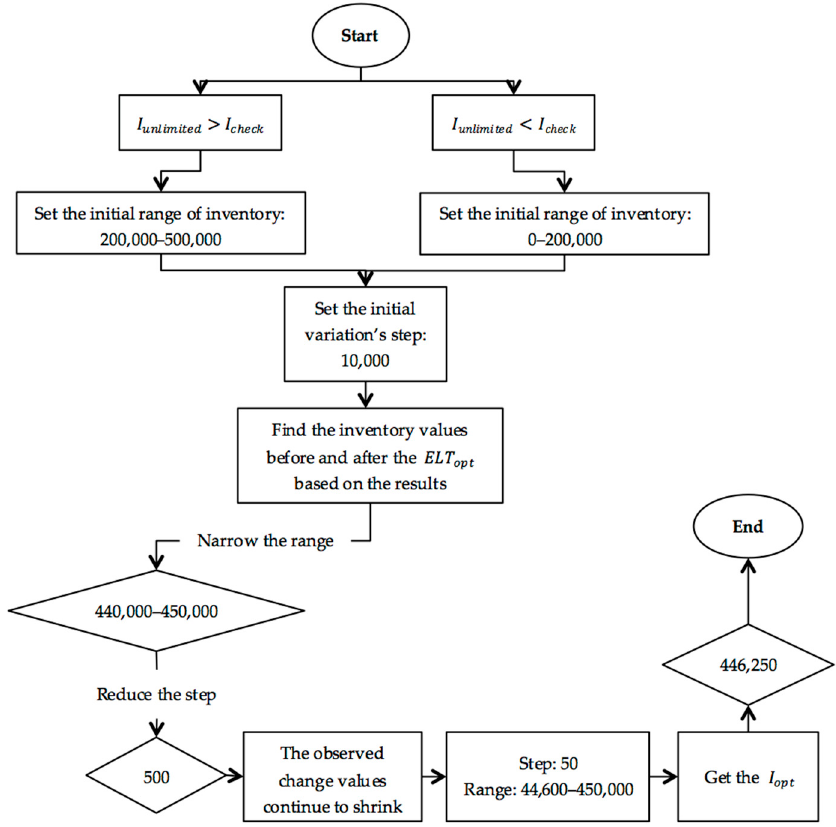
Figure 5. The variation and comparison experiment procedure.